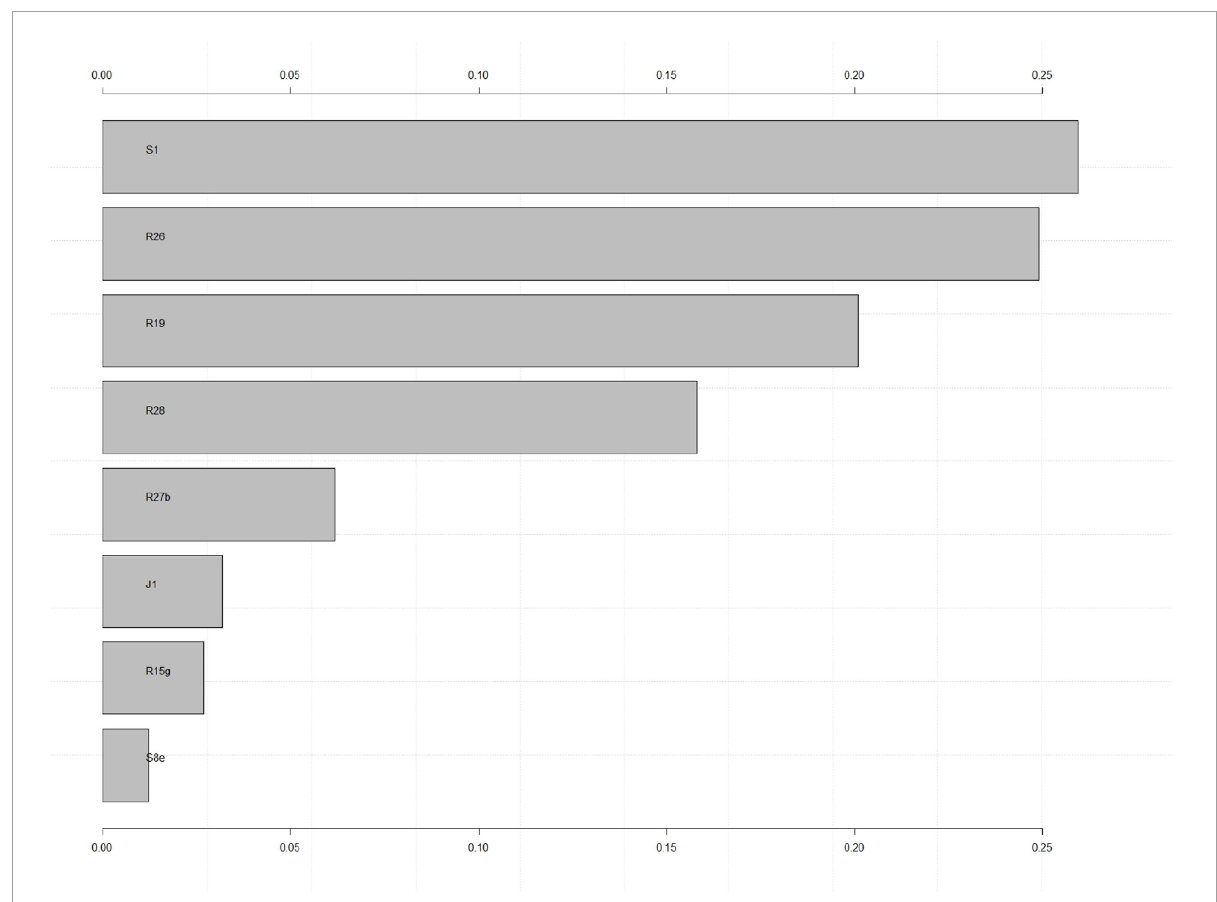
FIGURE2 S1, social isolation at time of offense; R26, insight into illness and its treatment; R19, insight in wrongfulness of offense during current hospitalization; R28, assigned legal prognosis at discharge; R27b, improvement of antisocial behavior during treatment; R15g, main content of psychotherapy: future perspectives; J1, time spent in prison > 1 year; S8e, Living situation at time of offense: at